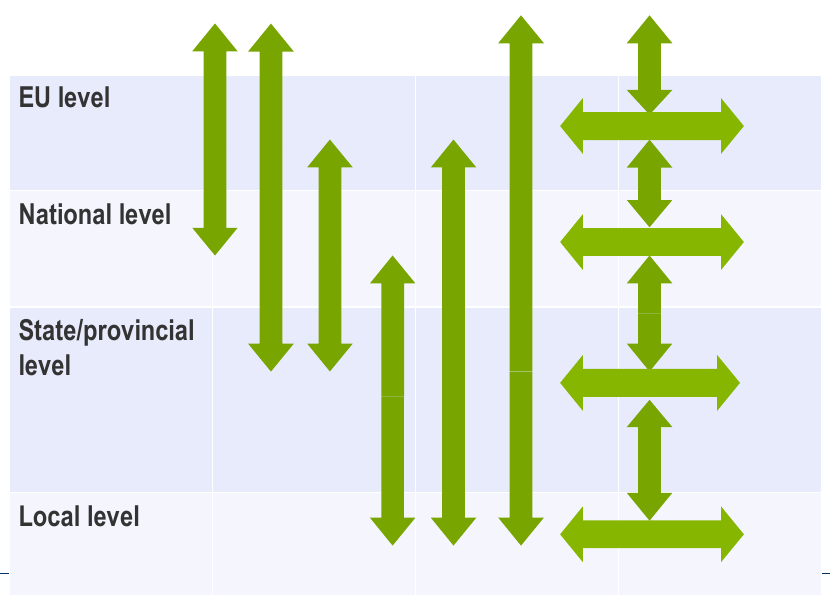
Figure 5. Multi-level governance: possible horizontal and vertical